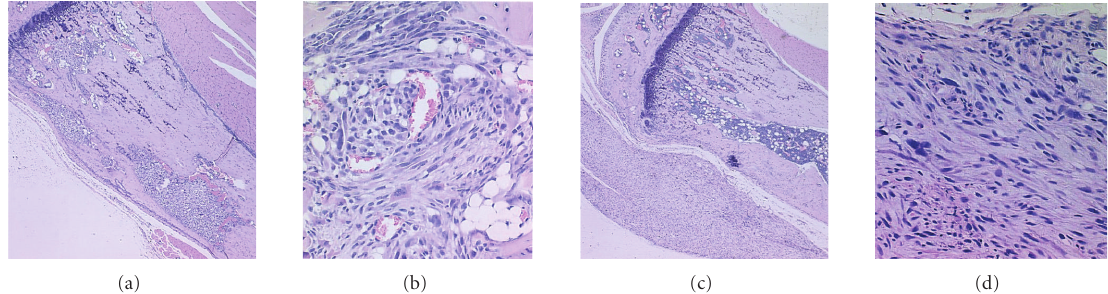
Figure 1: Two methods to establish the orthotopic tumors: panel (a) shows surgical exposure of the proximal tibia plus drilling a hole through cortical bone to accommodate osteosarcoma cells (25 × magnification); panel (b) shows a high magnification (200 × ) of orthotopic bone tumor with the surgical method. Panels (c) and (d) example the tumor by direct injection of tumor cells to proximal tibia, mostly out growth surrounding the bone (25 × and 200 × ).